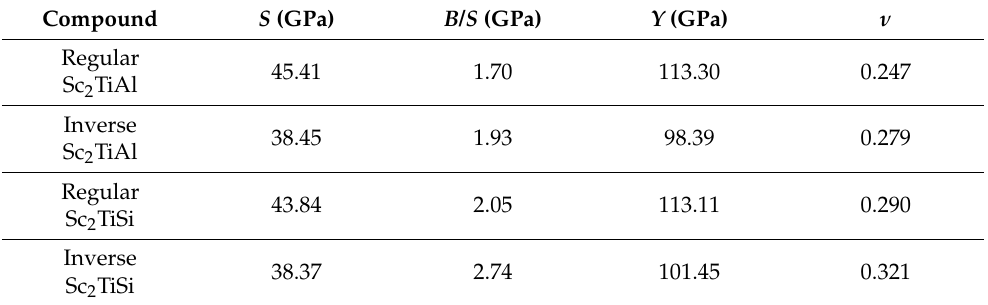
Table 4. Shear modulus ( S ), B / S ratio, Voigt Poisson’s ratio ( ν ), and Young’s modulus ( Y ) of Sc 2 TiAl and Sc 2 TiSi.